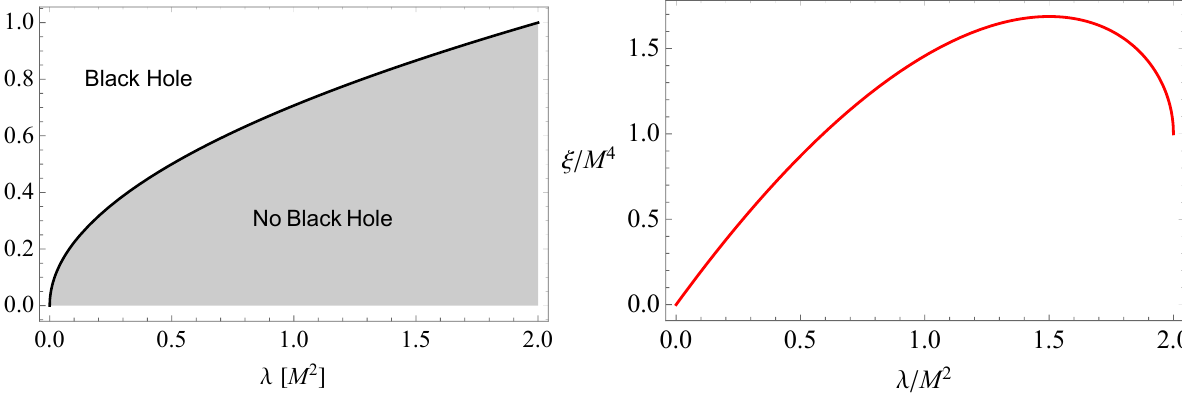
Figure 2. Left panel : Parametric plot between the mass of the black hole and the parameter λ . Right panel : Parametric plot between ξ and the parameter λ . We have set M = 1.